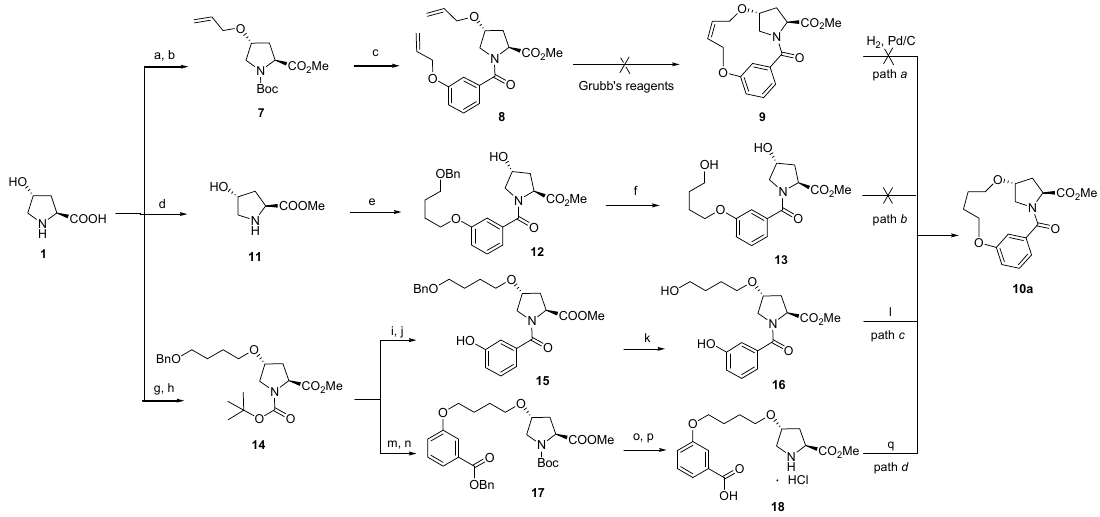
Scheme 2. Macrocyclization of 10a in four ways. Reagents and conditions : (a) (i) SOCl 2 , MeOH, reflux,